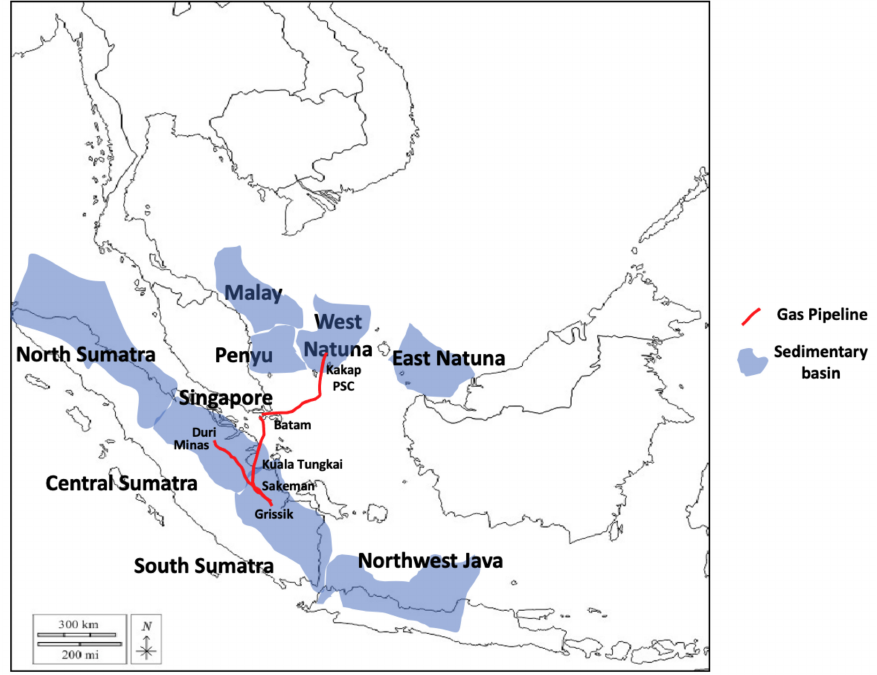
Figure 8. Natural gas pipelines supplying gas to Singapore from West Natuna field and Grissik field.